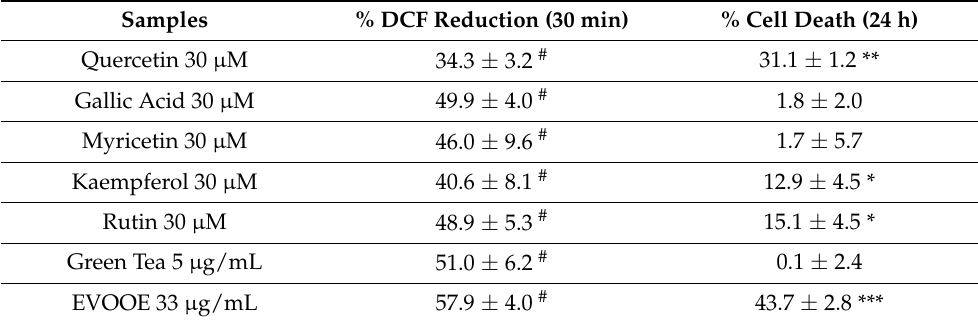
Table 1. Reduction of intracellular ROS and cell death induced by EVOOE in J82 cells.